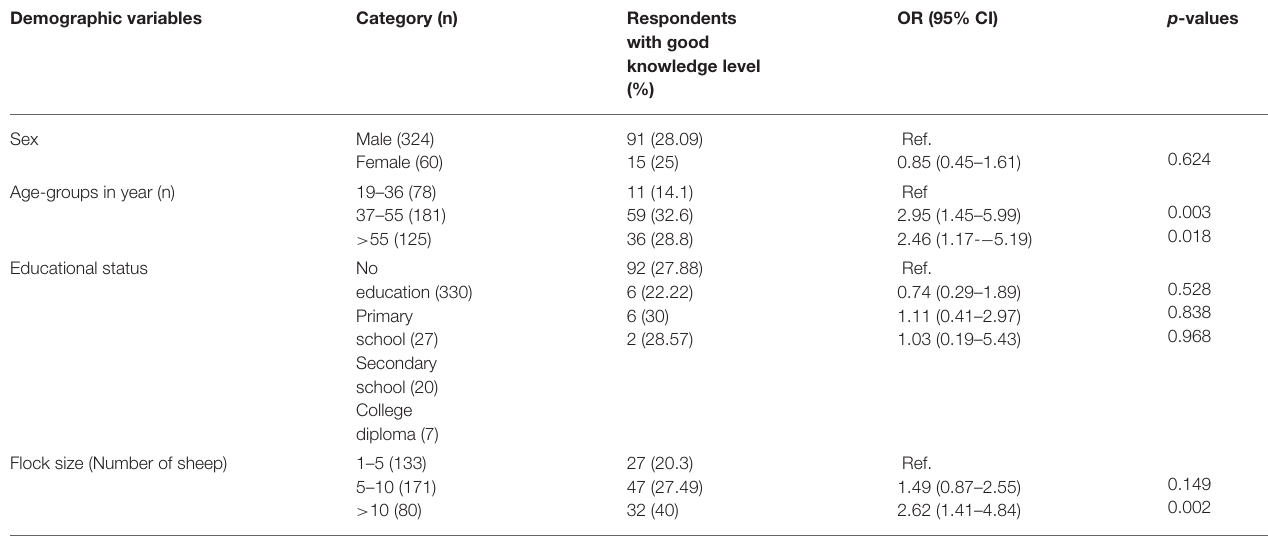
TABLE 7 | Association of demographic variables with knowledge level of participants about ovine pasteurellosis ( n =